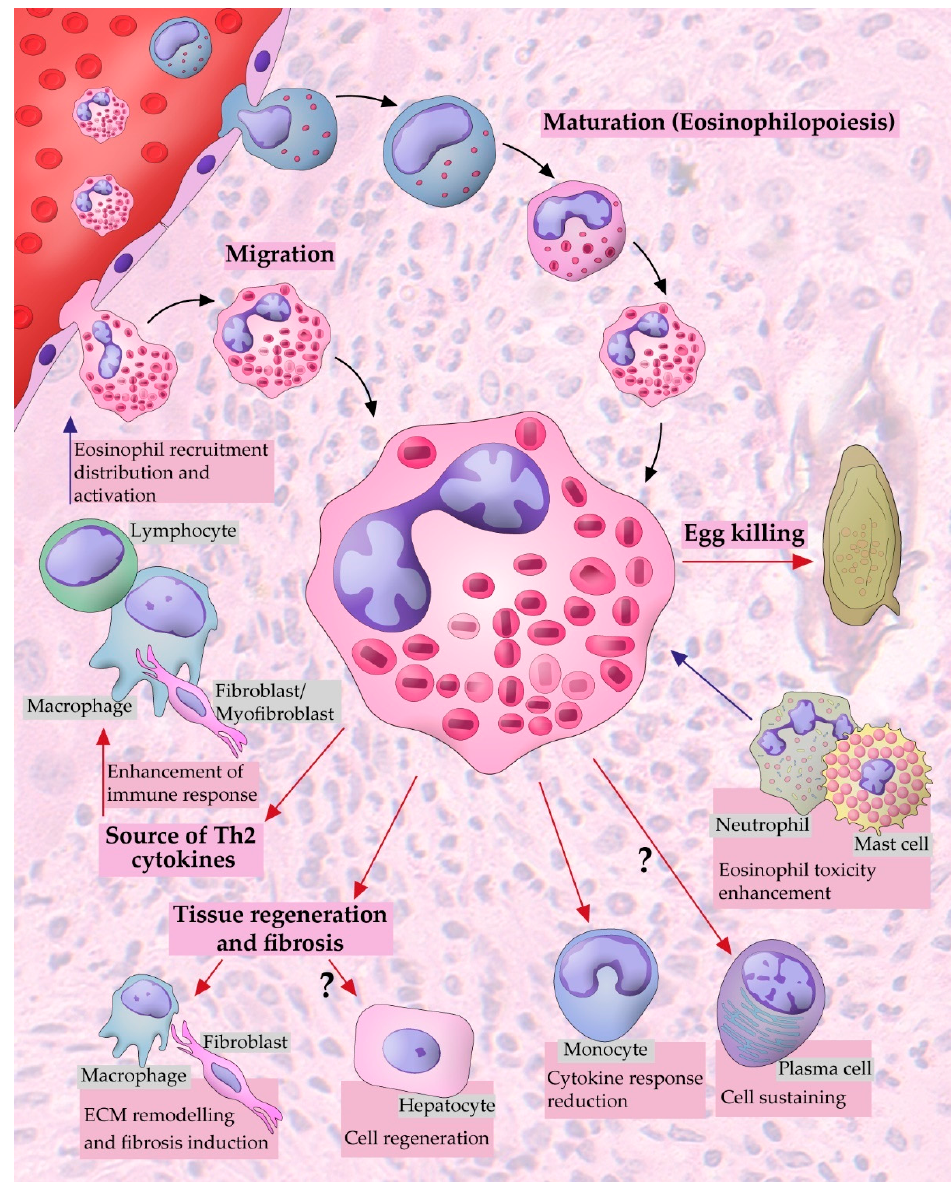
Figure 2. Eosinophil dynamics within a hepatic Schistosoma mansoni granuloma. Mature and im- mature eosinophils are recruited and migrate from the peripheral blood to target tissues, such as the liver. Undifferentiated eosinophils complete their maturation at the granuloma periphery (ex- tramedullary hematopoietic sites). Eosinophils populate the granuloma and potentially interact with both the egg and other cell populations. Eosinophils may have the following possible functional roles and interactions within the granuloma: (i) destruction of the parasite egg through the secretion of cationic proteins [103]; (ii) interaction with neutrophils and mast cells with a resulting increase in the eosinophil toxicity against the parasite egg [94,95]; (iii) plasma cell sustaining; (iv) interaction with monocytes resulting in decreased monocyte responses [97]; (v) induction of hepatocyte prolifer- ation/liver regeneration; (vi) interaction with macrophages and fibroblasts/myofibroblasts, with an impact on the extracellular matrix (ECM) remodeling and fibrosis induction [6,98]; (vii) enhancement of the immune response as a consequence of the eosinophil Th2 cytokines arsenal [90]; and (viii) in- teraction with lymphocytes, macrophages, and fibroblasts, which favors eosinophil recruitment, distribution, and activation